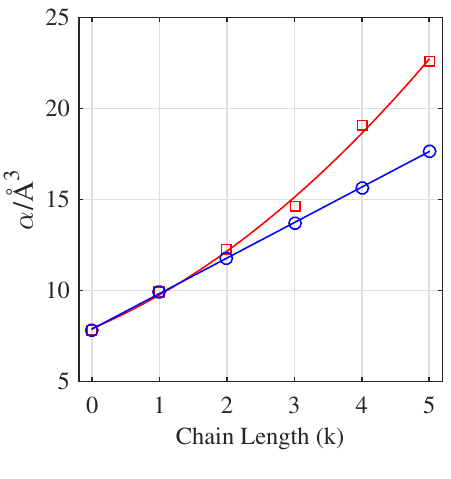
Figure 1. Electronic polarizability of [C k mim] + ( ◦ ) and [uC k mim] + ( □ ) cation families as function of the chain